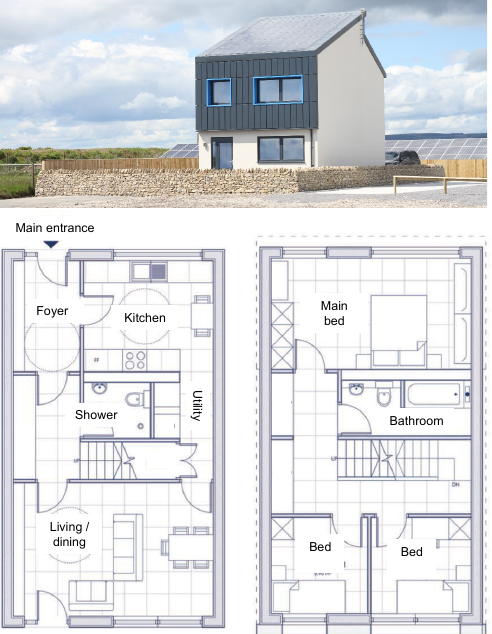
Figure 2. View of the south-facing elevation of the smart operation for a low carbon energy region (SOLCER) house and roof integrated solar PV array, with floor plans (600 mm grid).